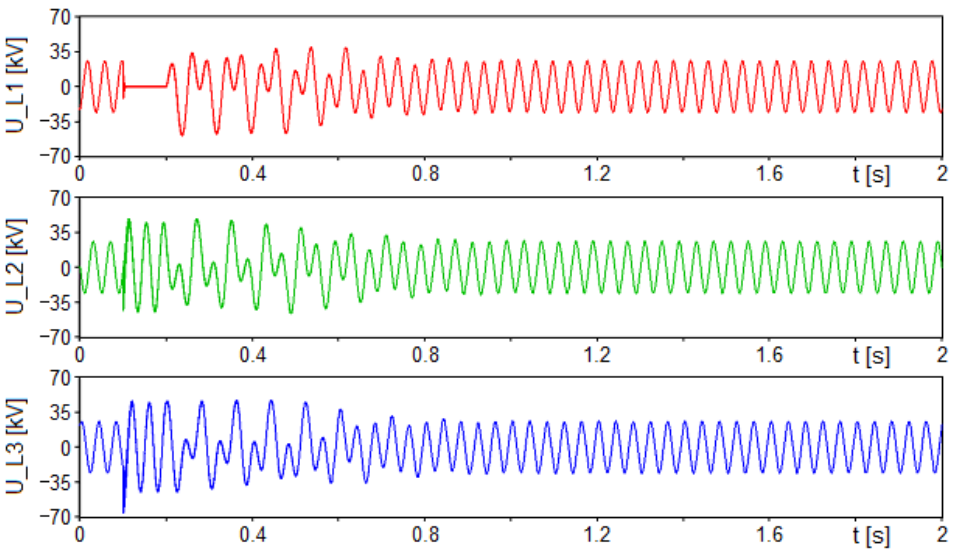
Figure 14. Waveforms of phase voltages on the primary side of voltage transformers, including the attenuation resistor R_OTD = 25 Ω in the additional winding system.